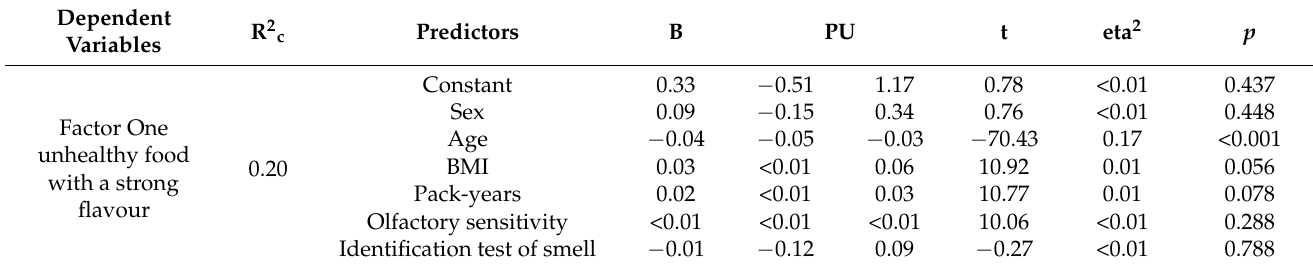
Table 3. The effect of predictors such as sex, age, BMI, pack-years, the n-butanol dilution step, odour identification of the group of dishes selected in the factor analysis as Factor One ‘unhealthy food with a strong flavour’; B—Unstandardised regression coefficients; PU—confidence interval; R 2 c —multiple determination coefficient; eta 2 -effect size; t—t Statistic; p —level of